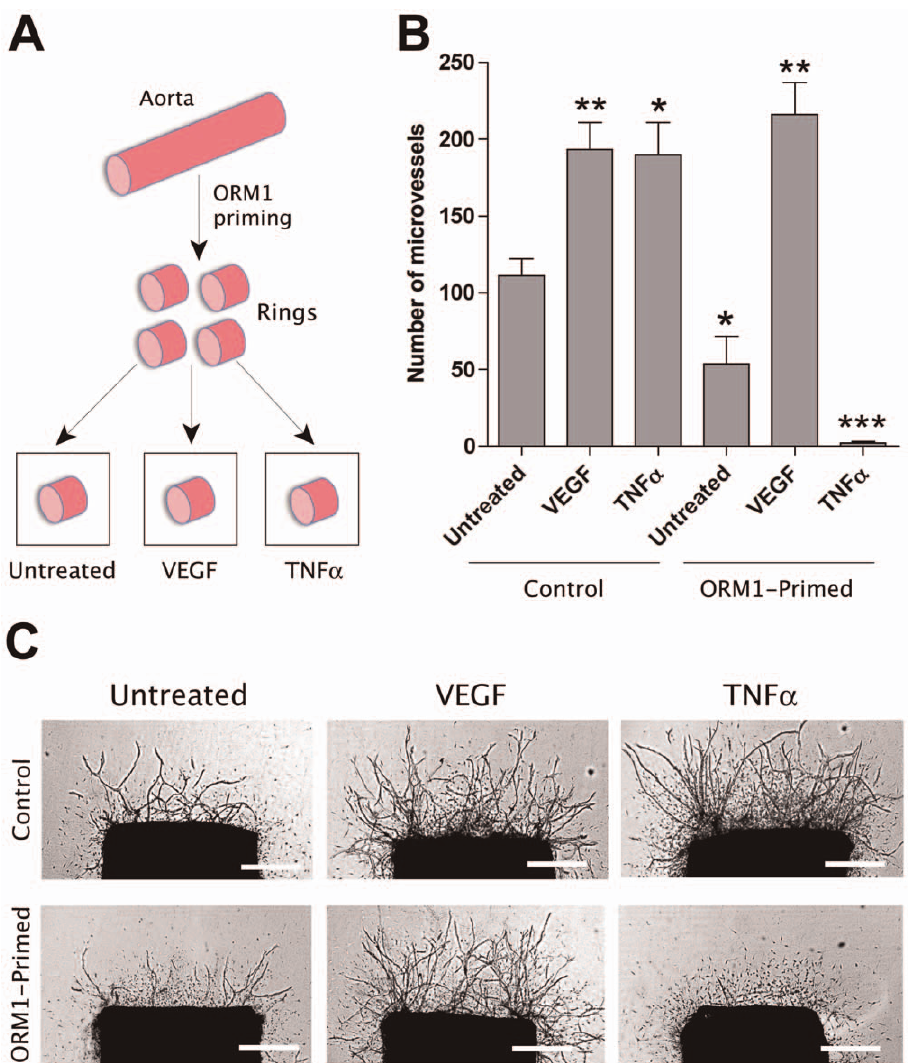
Figure 4. The angiogenic response of rings prepared from ORM1-primed aorta is markedly inhibited by TNF a but not VEGF. (A) Schematic drawing showing rings prepared from aortic tubes primed with 100 m g/ml ORM1 and then cultured in collagen gels with or without VEGF (10 ng/ml) or TNF a (10 ng/ml). (B–C). VEGF stimulates both control and ORM1-primed aortic rings whereas TNF a stimulates control rings but potently inhibits the angiogenic response of ORM1-primed rings. Magnification bars: 500 m m (C). N=4; *=p , 0.05. **=p , 0.01; ***=p ,